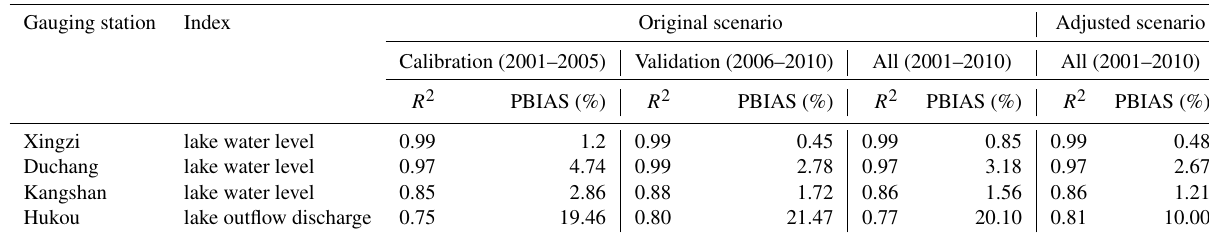
Figure 5. Comparison of the observed (red dotted line) and simulated (black solid line) lake water level at Xingzi, Duchang, and Kangshan stations and outflow discharges at Hukou by the Delft3D model. The calibration period and validation period are from 2001 to 2005 and from 2006 to 2010, respectively. R 2 c , PBIAS c and R 2 v , PBIAS v are the calibration (from 2001 to 2005) and validation (from 2001 to 2005) results, respectively. Table 4. Quantitative assessment of calibration and validation for stream flow simulation for the Delft3D